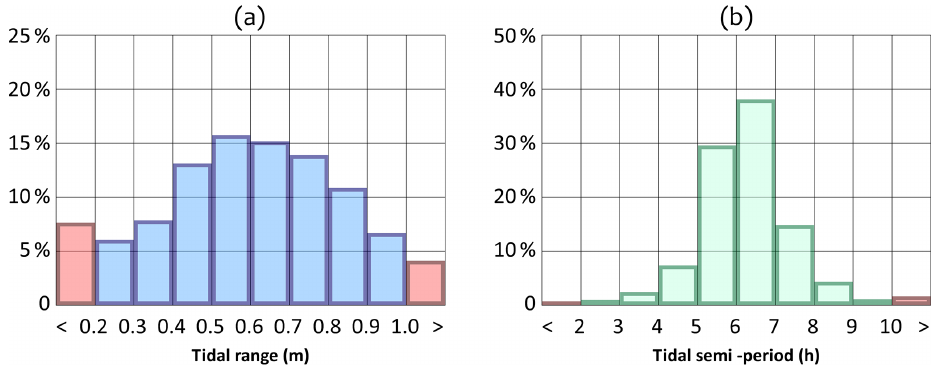
Figure 2. Dataset 2000–2019, Punta della Salute (PS). Frequency distribution of tidal range (a) and tidal semi-period (b) . Data refer to flood